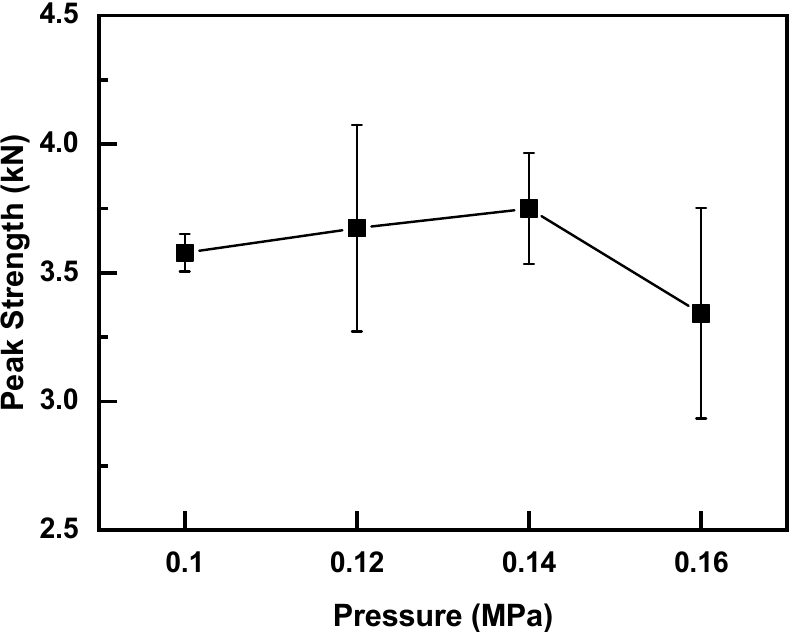
Figure 7. Effect of welding pressure on the joint strength (Preload of 200 N and welding time of 2.5 s).